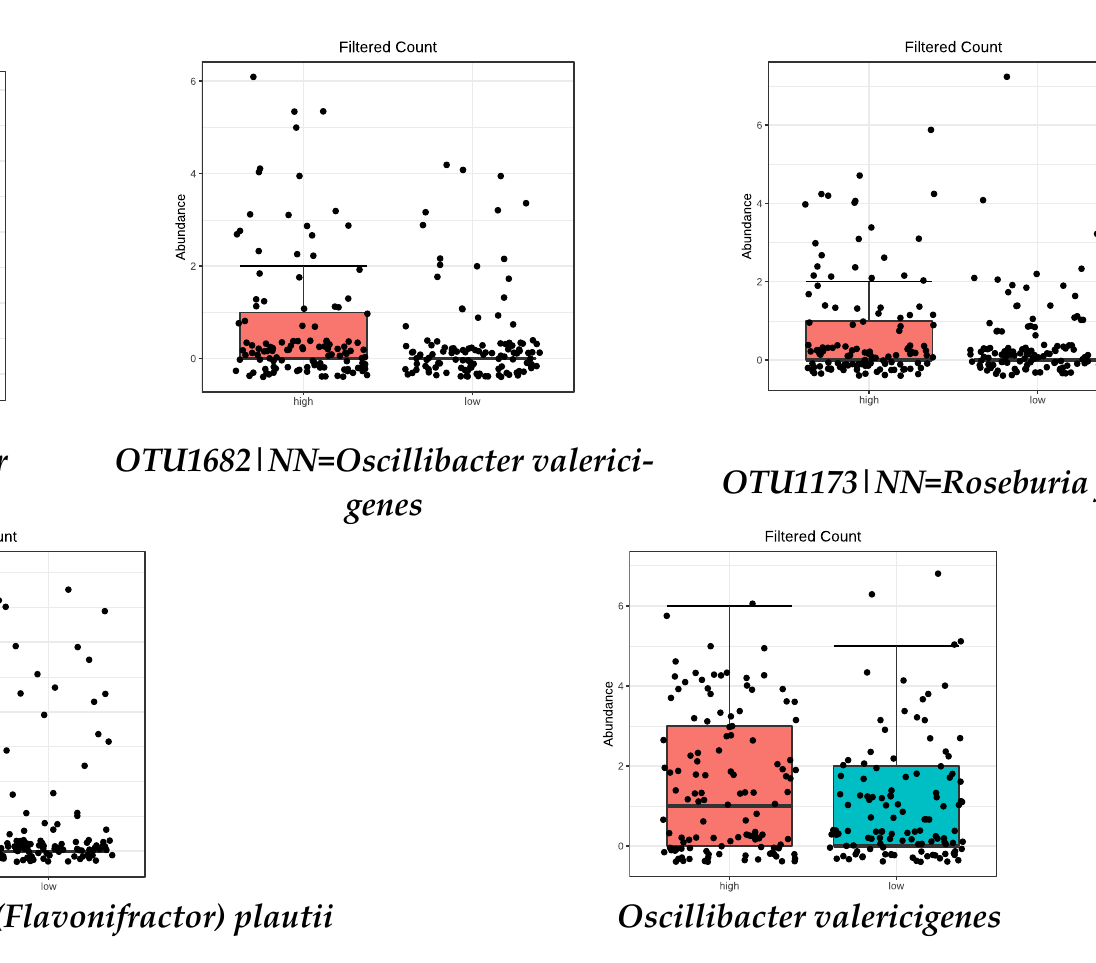
Figure 2. Bacterial species that show significant relation with high FIBRE intake (FDR < 0.05) by metagenomeSeq test. Red boxes represent participants with a higher adherence to the MD and blue boxes low adherence.